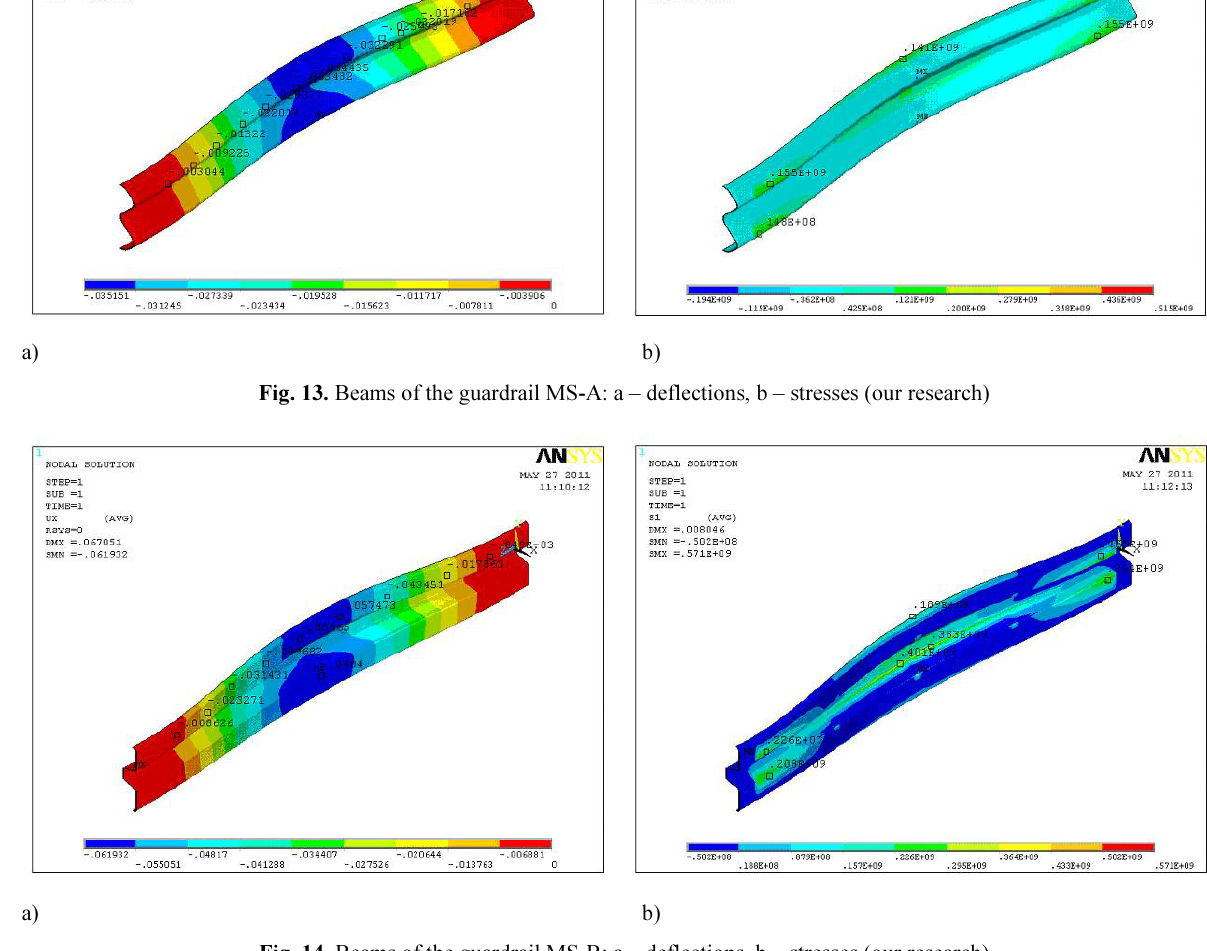
Fig. 14. Beams of the guardrail MS-B: a – deflections, b – stresses (our research)